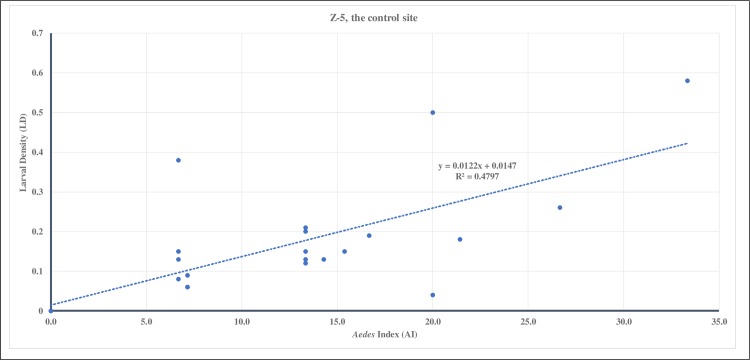
For 2015, the regression relationship between larval density (LD) and Aedes index (AI) during the 23 weeks of entomological surveillance conducted in Z-5, the control site.There was a moderate positive correlation (R2 = 0.48) between LD and AI.